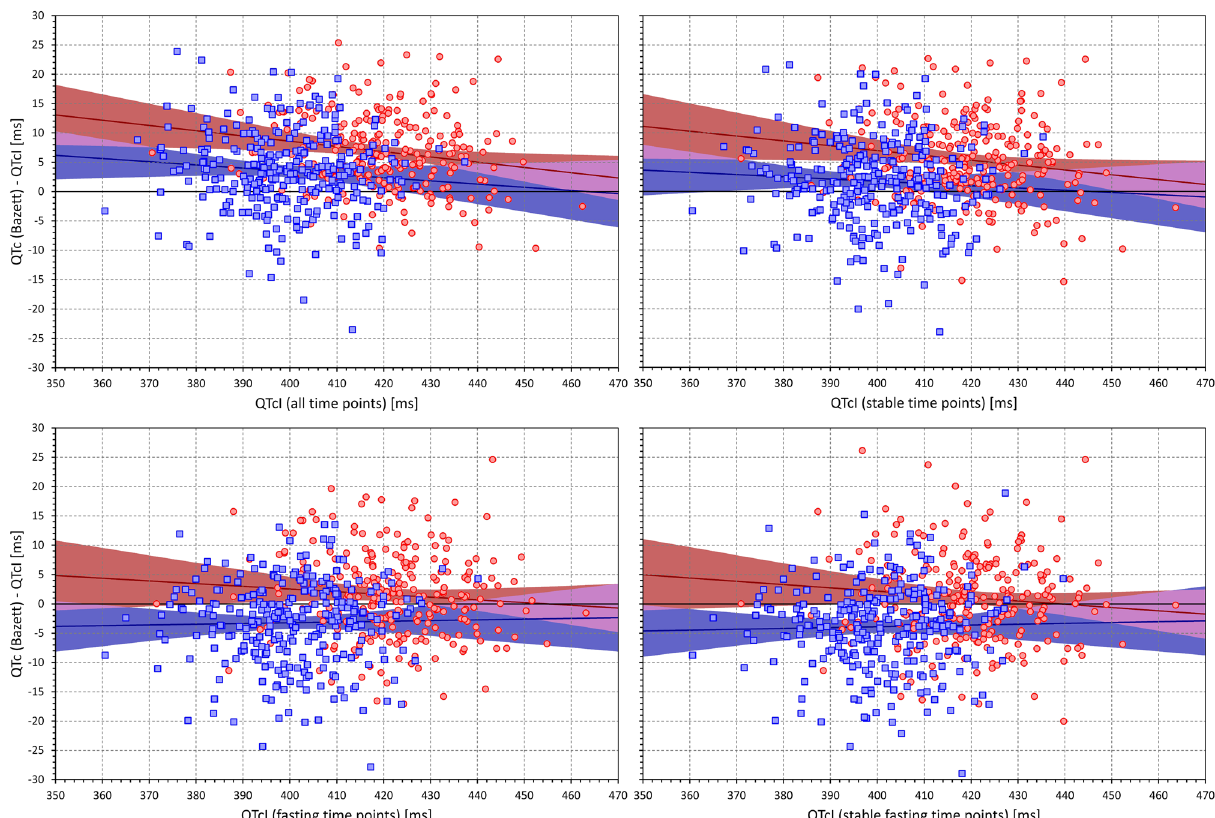
Figure 13. Scatter diagrams of the mean intra-subject differences between Bazett corrected QTc intervals and corresponding QTcI intervals plotted against the intra-subject means of QTcI intervals. The diagrams are shown for data of all study time-points (top left panel), time-points with stable heart rate (top right panel), morning fasting time-points (bottom left panel), and morning fasting time-points with stable heart rate (bottom right panel). In each panel, the red circles and blue squares correspond to female and male subjects, respectively. The solid red and solid blue lines show the linear regressions between the intra-subject QTcI means and the mean intra-subject QTc – QTcI differences in females and males, respectively. The red shaded and blue shaded areas are the 95% confidence intervals of the regression lines; the violet areas are the overlaps between the confidence intervals of the sex-specific regressions. ms